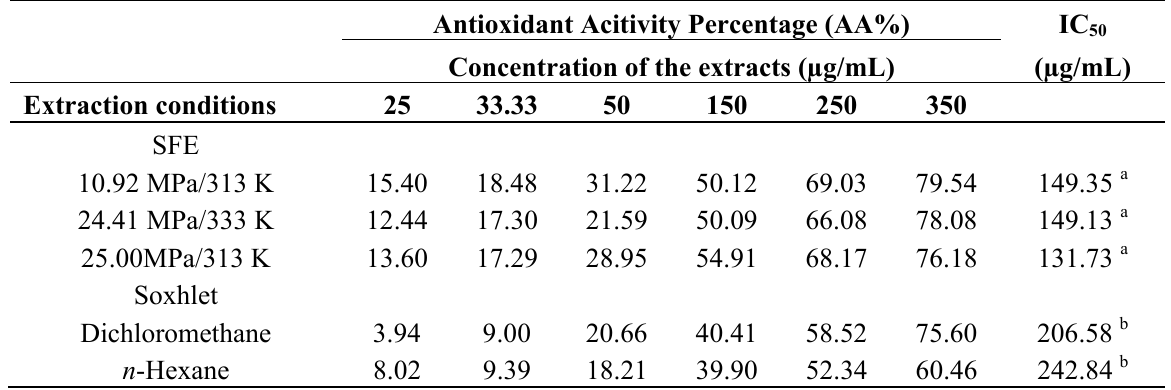
Table 4. Antioxidant activity data (%) obtained for SFE and Soxhlet extracts by the DPPH